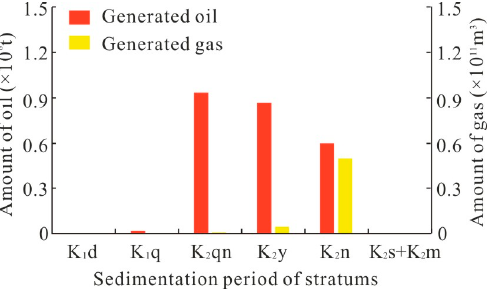
Figure 8. The amounts of hydrocarbon generation from K 1 yc 4 in the South Shuangcheng Fault De-